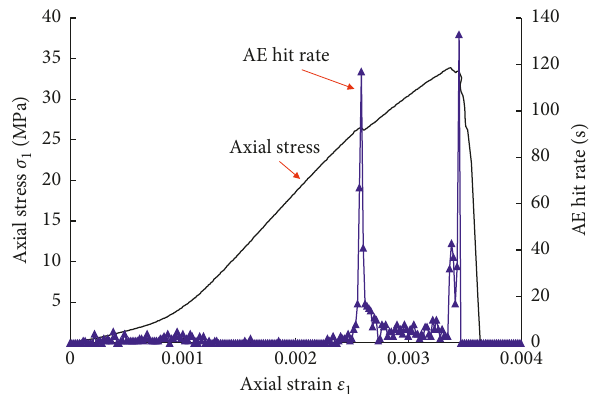
Figure 4: Stress-strain and AE hit curve of the specimen